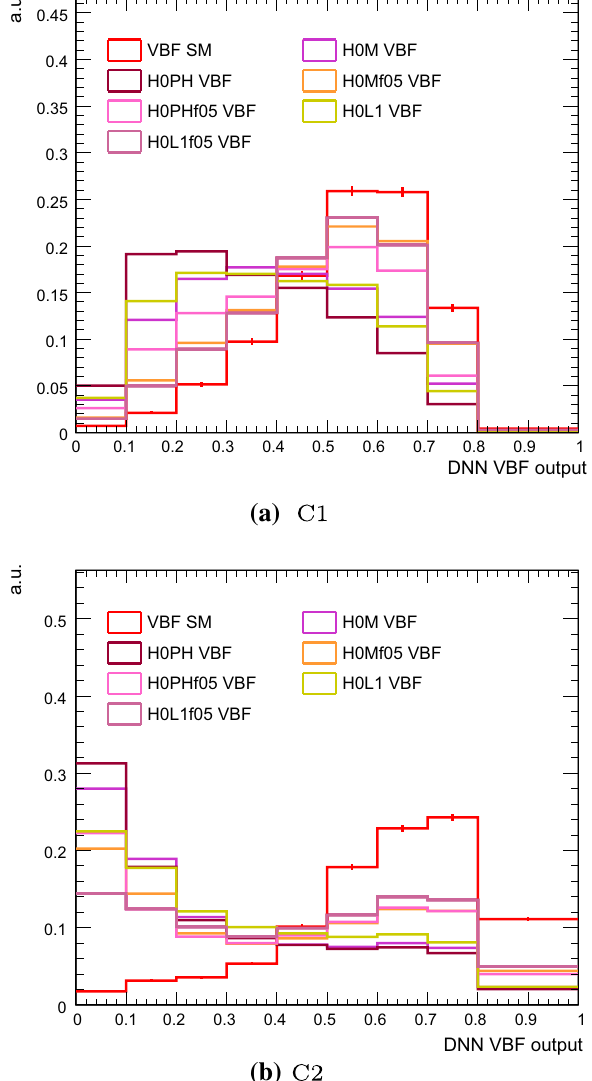
Fig. 8 Normalized distribution of the VBF-output of both the DNNs in the corresponding STXS bin. The uncertainty associated with the limitedsize of simulated samples is reported only in the SM distribution , T albeit less than in the case of the SM-trained DNN,